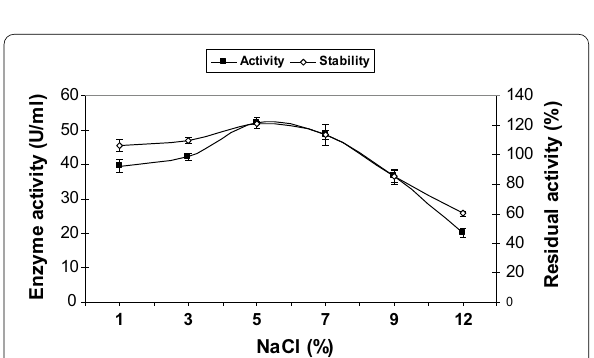
Fig. 3 Activity and stability of l -glutaminase produced by Bacillus sp. DV2-37 as a function of NaCl concentrations. Results are means of three independent determinations. Data represent the mean of 3 different readings standard deviation ±